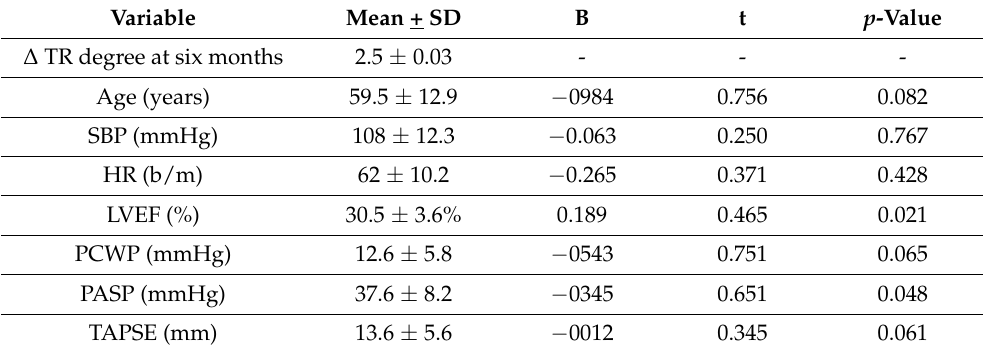
Table 3. Multiple linear regression analysis of the ∆